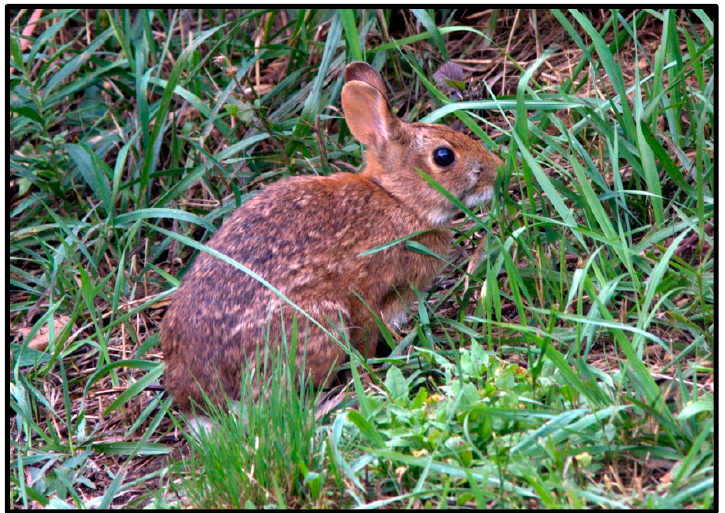
Figure 1. New England cottontails are dependent on dense understory vegetation that provides food and cover. Such vegetation has become rare in recent decades. Photo courtesy of Linda Cullivan.